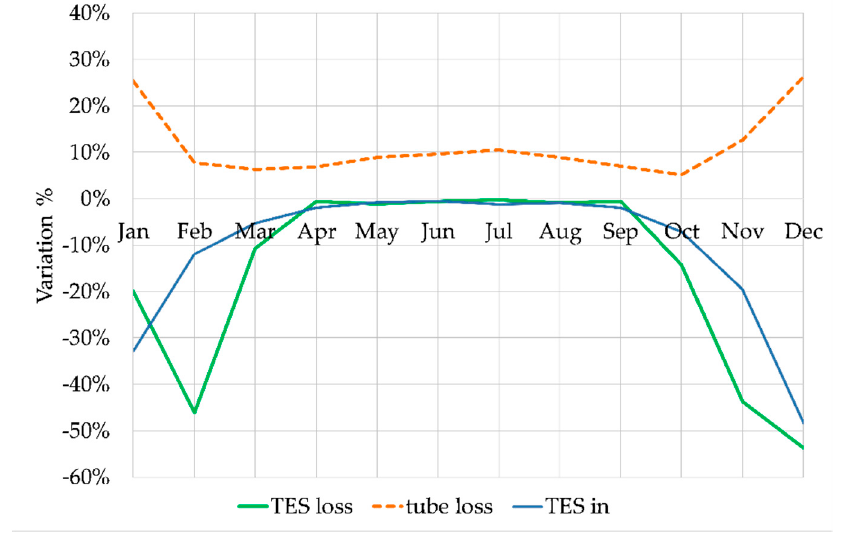
Figure 11. ( a ) Cumulative hours of LFR defocusing in the multiple and single LHTES yearly simulation; ( b ) cumulative hours of power exchanged by each module.